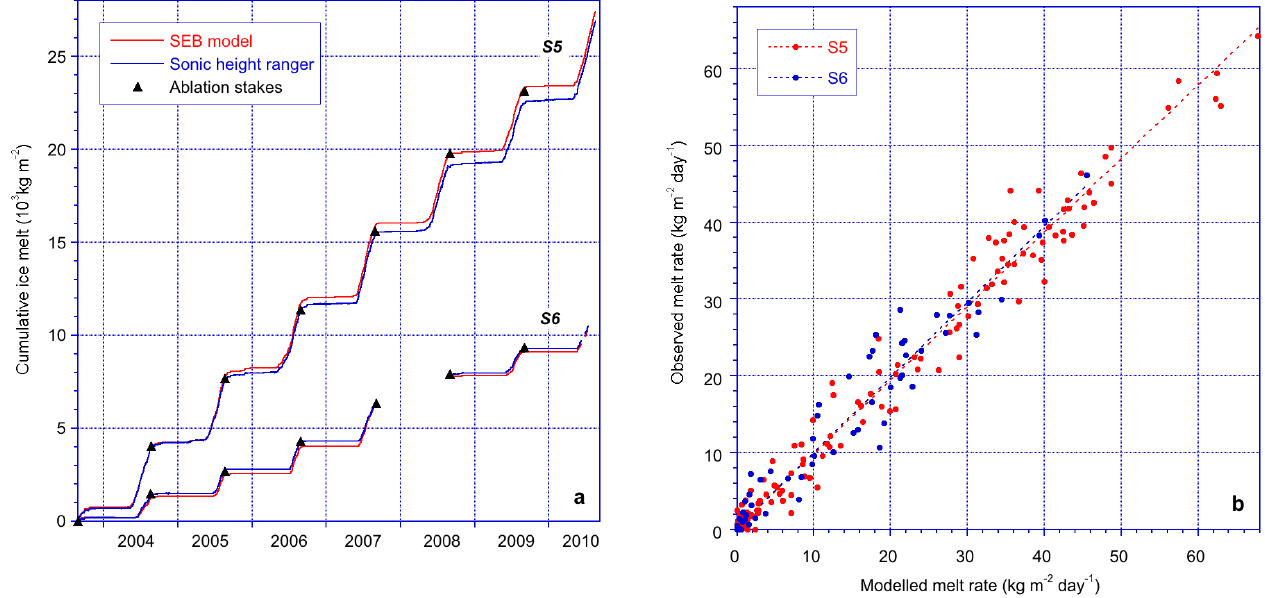
Fig. 4. (a) Observed (blue line) versus modelled (red line) cumulative ice ablation at S5 and S6. Cumulative ice melt from annual stake measurements are indicated by triangles. (b) Observed versus modelled 10-day average ice melt rates at S5 (red dots) and S6 (blue dots). The dashed lines are linear regressions on the